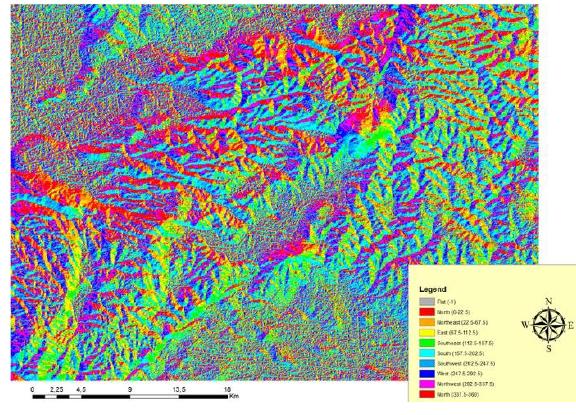
Figure 7. Aspect layer, Syrian Limestone